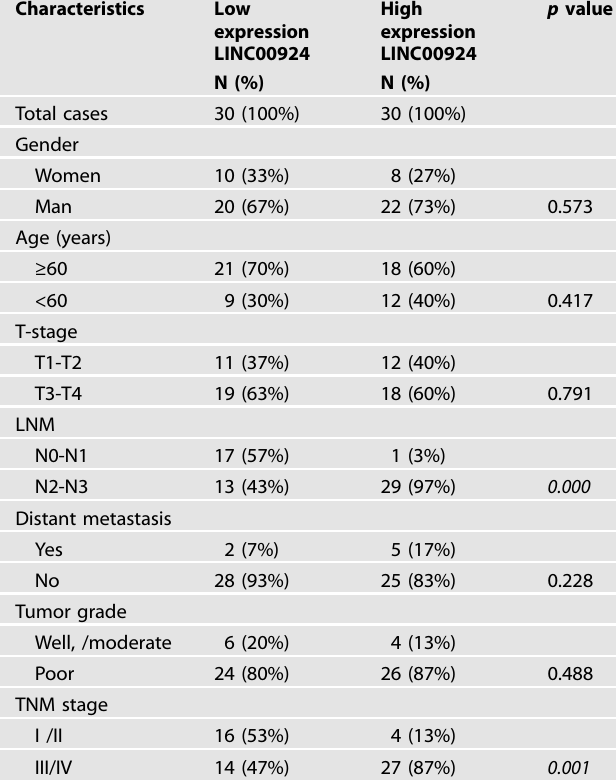
Table 1. the correlation of LINC00924 expression with the clinicopathological parameters of GC patients ( n =